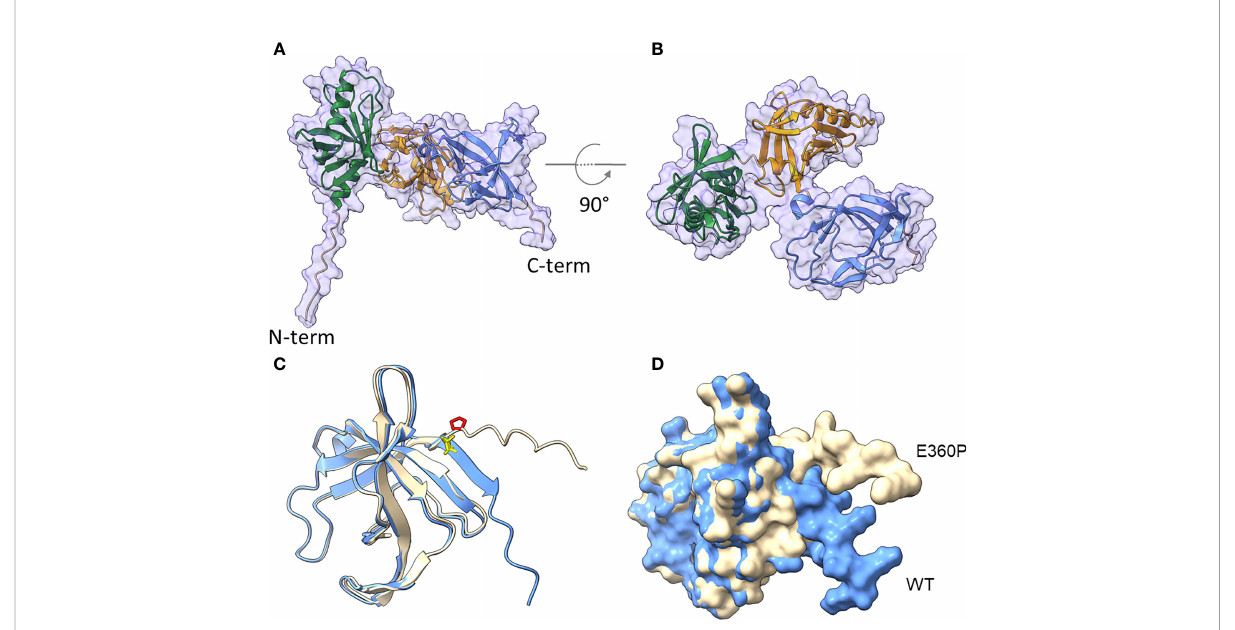
FIGURE 5 Structural prediction of CipA obtained with AlphaFold2. The mature CipA 18-369 protein has a short, 11 amino acid-long unstructured N-terminus (A) , followed by three approximately equally sized domains (B) , recognized as META domain 1 (AA 46-107), META domain 2 (AA 151-253) and a C-terminal domain of unknown function, DUF4377 (AA 277-361). The DUF4377 domain is made up entirely of beta-sheets, the last of which contains the E360 residue in WT CipA (blue, E360 highlighted in yellow in (C) which was mutagenized to proline in the E360P mutant (beige, P360 highlighted in red in (C) . Introduction of this amino acid disrupts the fi nal beta-sheet strands and results in reorientation of the last 9 C- terminal amino acids (D) , away from the DUF4377 domain, but without any overt effect on the other parts of the